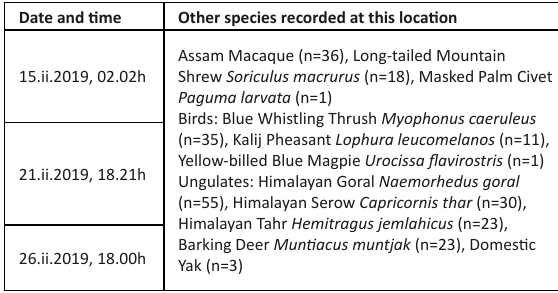
Table 1. Details of Asiatic Golden Cat recorded in Lapchi Valley of Gaurishankar Conservation Area, with independent images of other